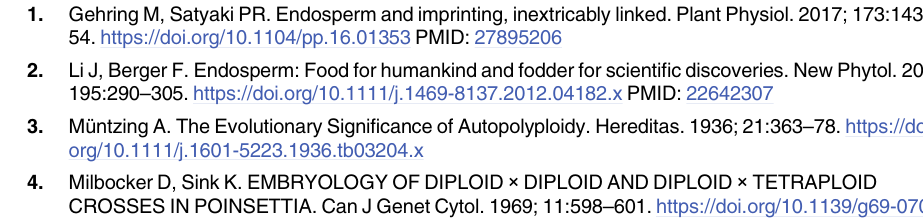
S6 Data. Data underlying S7 Fig. Analysis of the relationship between changes in sRNA and mRNA abundance. sRNA, small RNA. S7 Data. Data underlying S8 Fig. Analysis of the relationship between changes in DNA meth- ylation and mRNA abundance. S8 Data. Data underlying S9 Fig. Analysis of the impacts of mat and pat nrpd1+/− on allelic contributions to mRNA